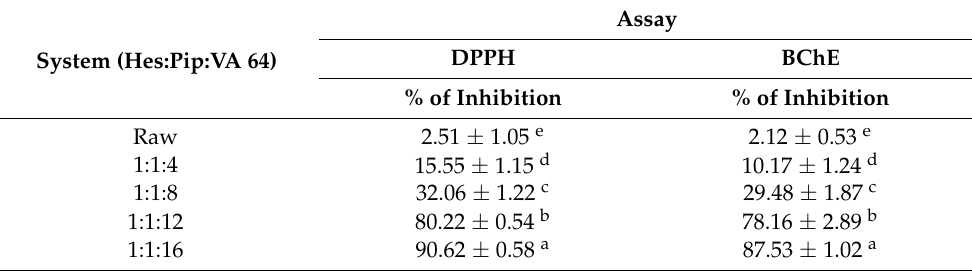
Table 2. The results of amorphous systems’ improved inhibition activities against DPPH radicals and